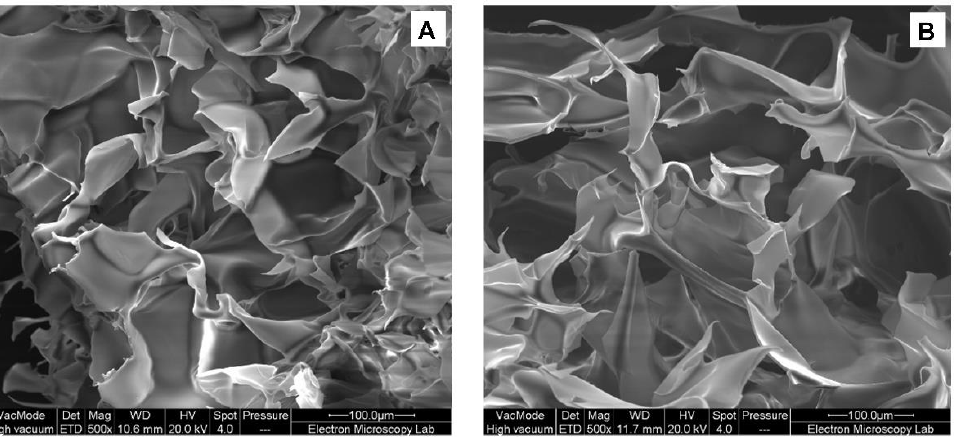
Figure 3. SEM images of: ( A ) HPMC-L gel, ( B ) HPMC-H gel at 500×. Micrographs were obtained under vacuum, no pressure was recorded (---).